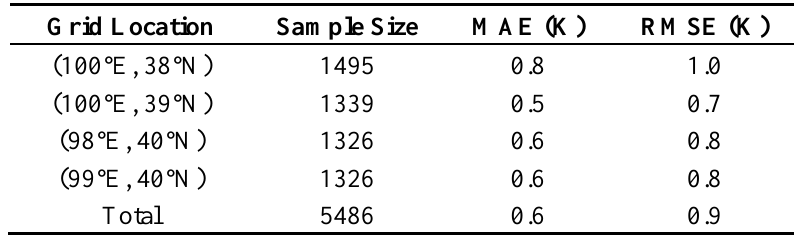
Table 8. Validation of the RM-GA method with simulations of GDAS profiles in the study